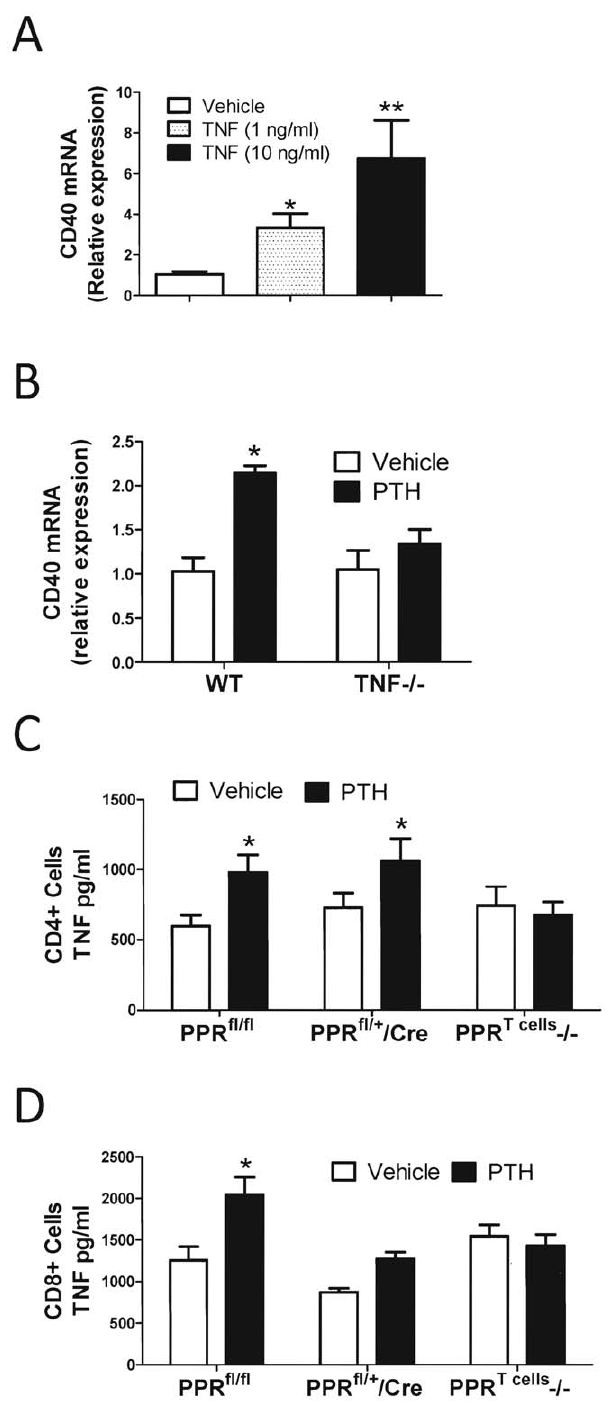
Figure 4. Regulation of SC CD40 expression and T cell TNF production. A Effect of in vitro TNF treatment on CD40 mRNA expression by SCs. B Effect of in vivo cPTH treatment on CD40 mRNA levels in SCs from WT and TNF 2 / 2 mice. C Effect of in vivo cPTH treatment on TNF mRNA and TNF protein production by CD4 + cells from PPR T cells 2 / 2 and control mice. D Effect of in vivo cPTH treatment on TNF mRNA and TNF protein production by CD8 + cells isolated from PPR T cells 2 / 2 and control mice. All data are expressed as mean 6 SEM. *=p , 0.05 and *=p , 0.01 compared to the corresponding vehicle group. n=6 mice per